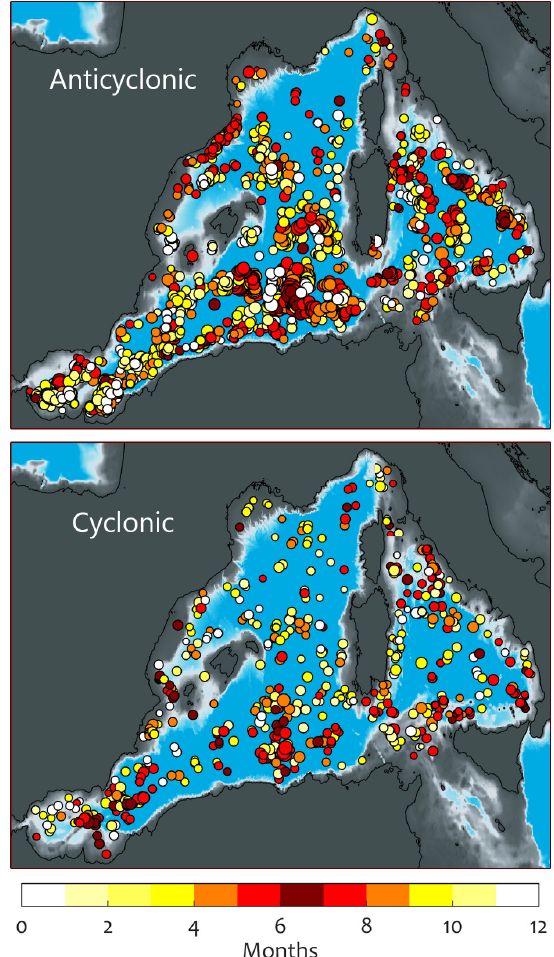
F igure 7. Absolute counts of eddy diameters for AC and C Figure 5. Spatial distribution of mesoscale eddy manifestations eddies detected in the Western found in the fields of SST in 2008 and 2014 in the Western Mediterranean